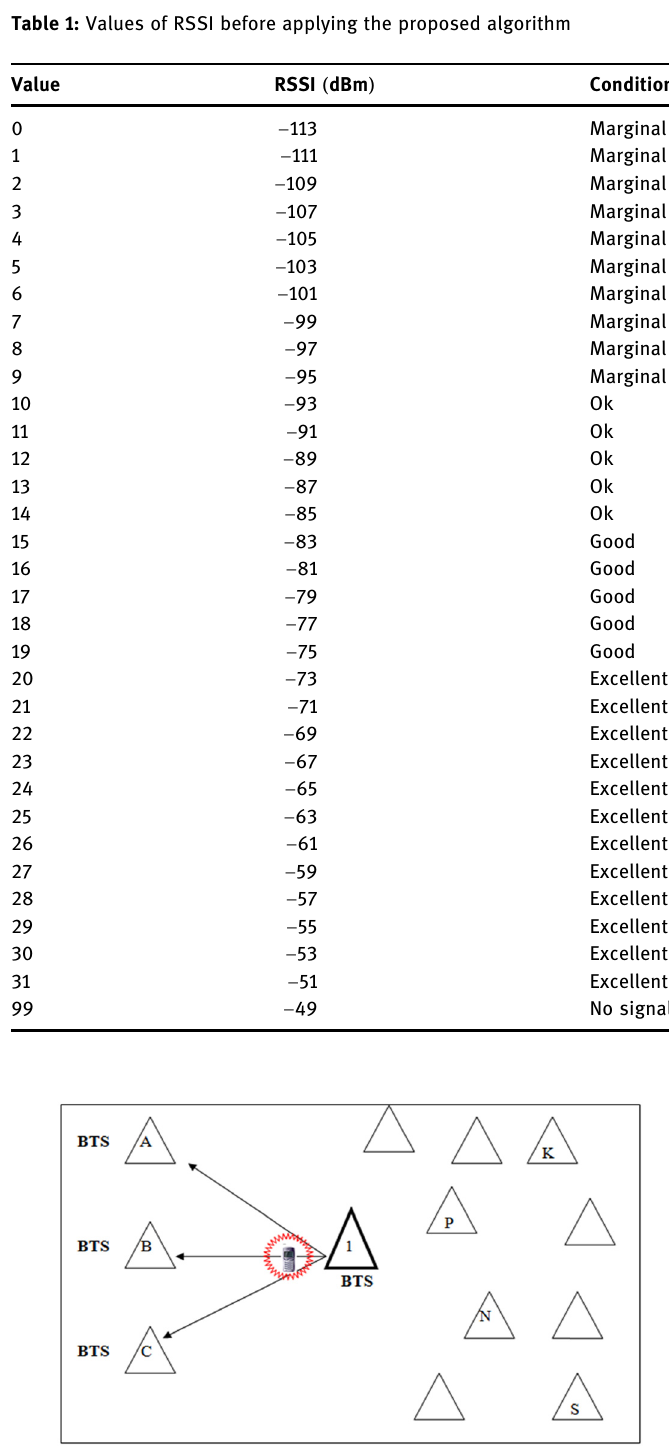
(cid:129) Collecting the information from the previous steps will determine the distance between the mobile phone and the coverage holes as well as the identi fi cation of both BTSs that the mobile phone located between them.